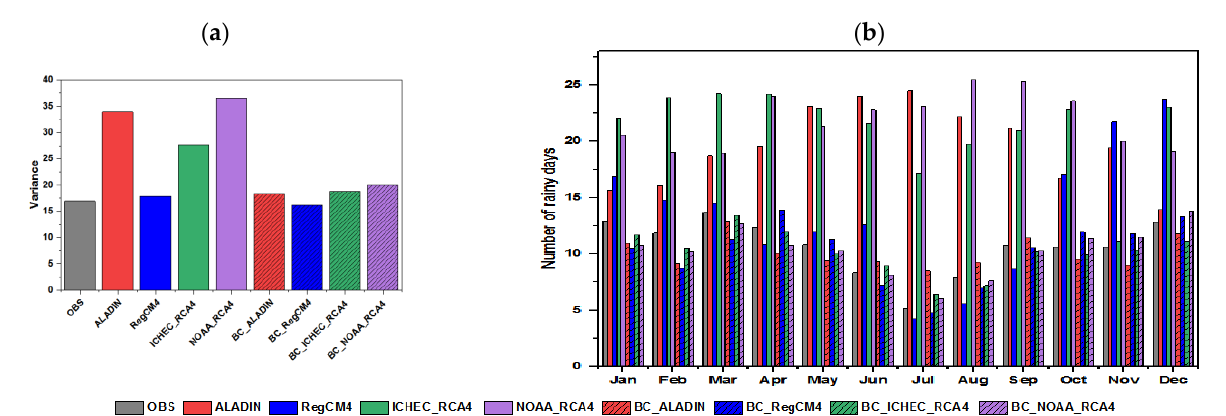
Figure 3. Grouped columns shows ( a ) the variance of raw, corrected RCMs and observational annual cycle of daily precipitation over the historical period (1970–2005) and ( b ) the number of rainy days of raw, corrected RCMs, and observational monthly cycle over (1970–2005).